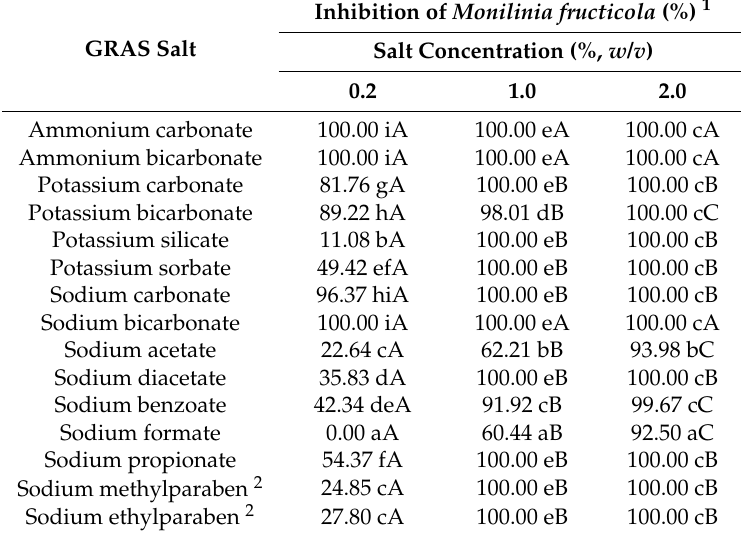
Table 1. Percentage inhibition of radial growth of Monilinia fructicola on potato dextrose agar (PDA) Petri dishes amended with different concentrations of GRAS salts after 7 days of incubation at 25 ◦